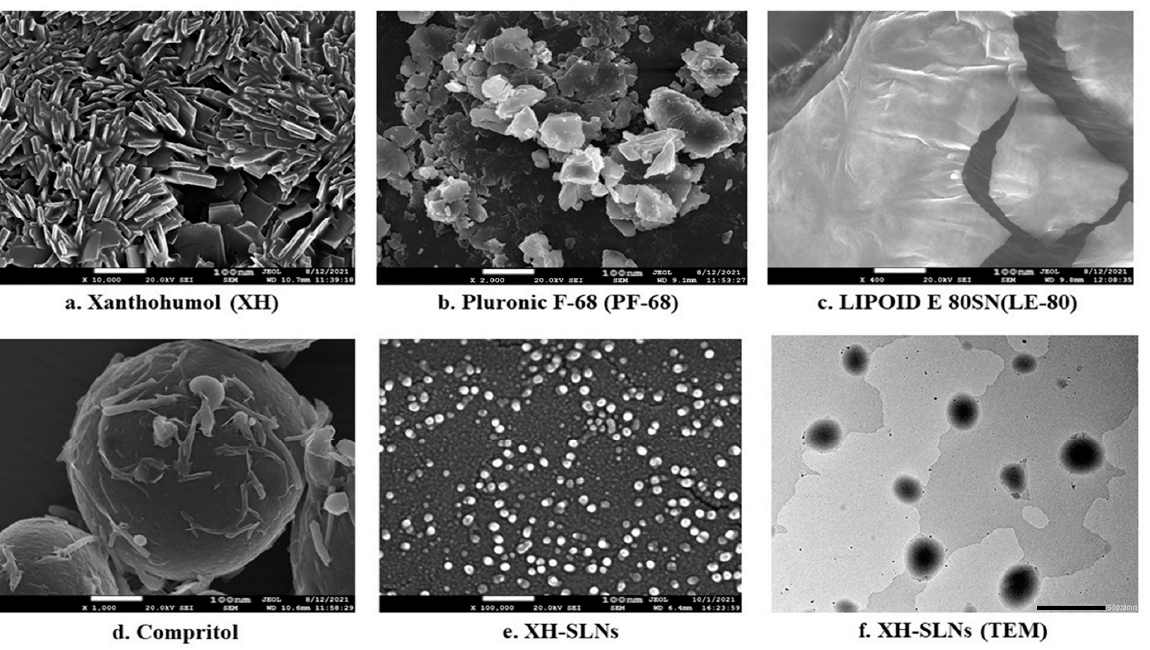
Figure 8. FE-SEM images of ( a ) Xanthohumol; ( b ) Pluronic F-68; ( c ) Lipoid E 80SN; ( d ) CE; ( e ) XH- SLNs and HRTEM images of ( f ) XH-SLNs.